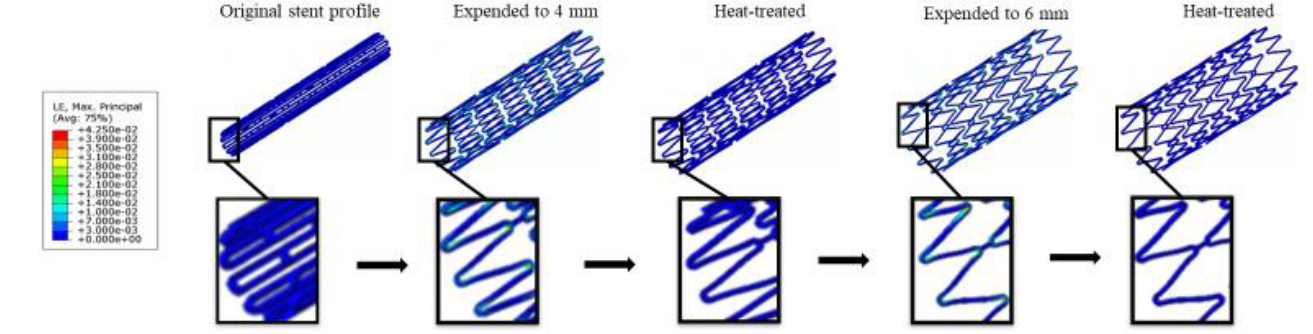
Figure 7. Contour plot comparison of strain distribution during multiple expansions and corresponding heat treatments for the standard design.